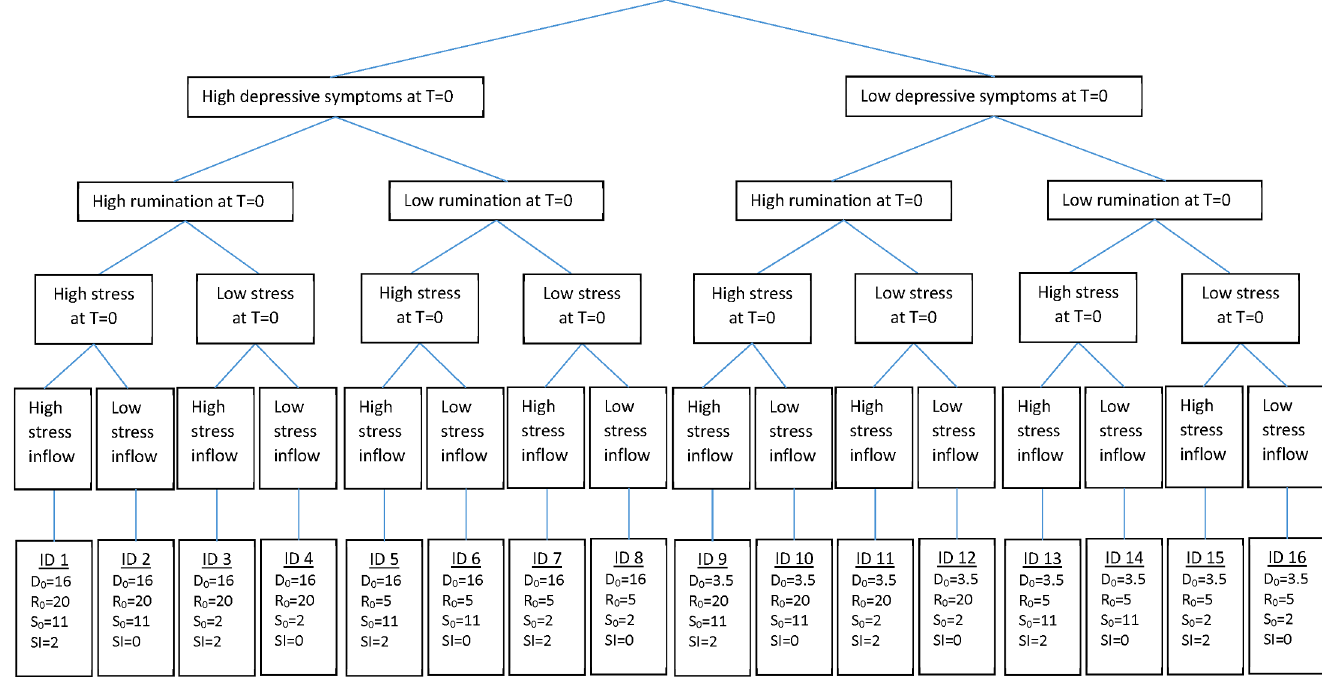
Fig 3. Sixteen categories of girl participants. D 0 , R 0 , S 0 , and SI represent initial depressive symptoms and rumination, prior stressors, and ongoing stressors, respectively.